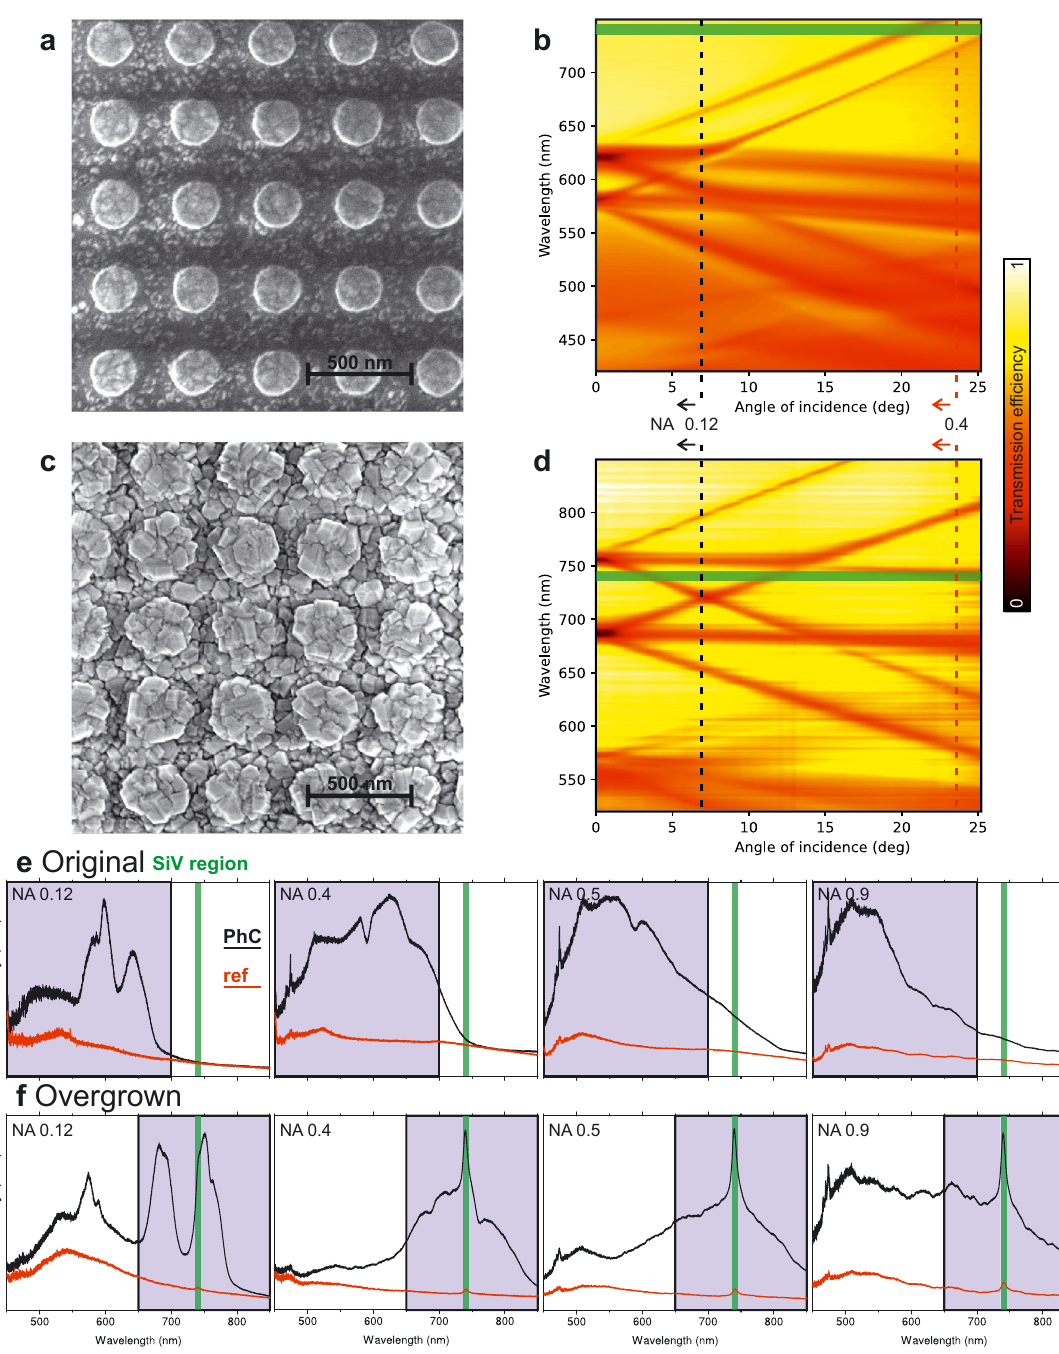
Figure 3: Scanning electron microscopy (SEM) images and measured transmission spectra (along Γ – X direction) of the original sample (a, b) and the sample after deposition of the tuning layer (c, d). (e) Photoluminescence (PL) spectra measured on the original structure (black on photonic crystal [PhC], red on reference layer; the green rectangle shows the spectral position of the SiV center zero-phonon line [ZPL]). (f) PL spectra measured on the structure with the tuning